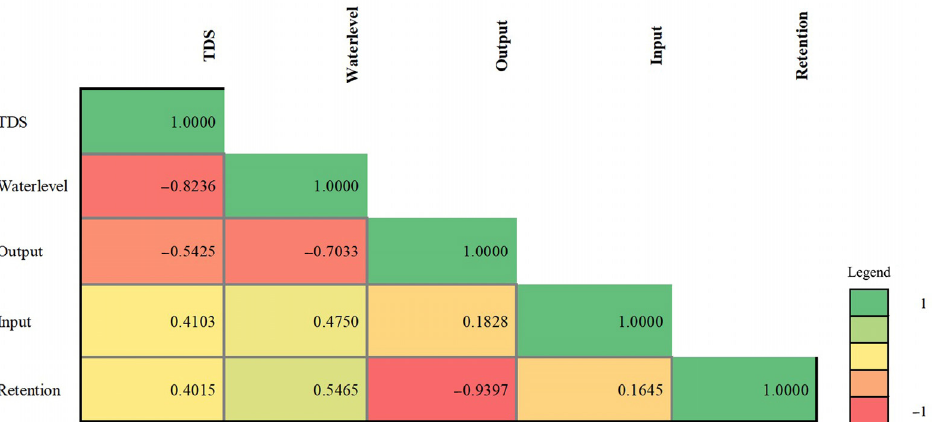
Figure 4. Correlation heatmap between TDS content (TDS) and water level, TDS amount into the lake (Input), TDS amount out of the lake (Output), and TDS amount retained in the lake (Retention). In fact, water movement and water exchange have always been weak in Bosten